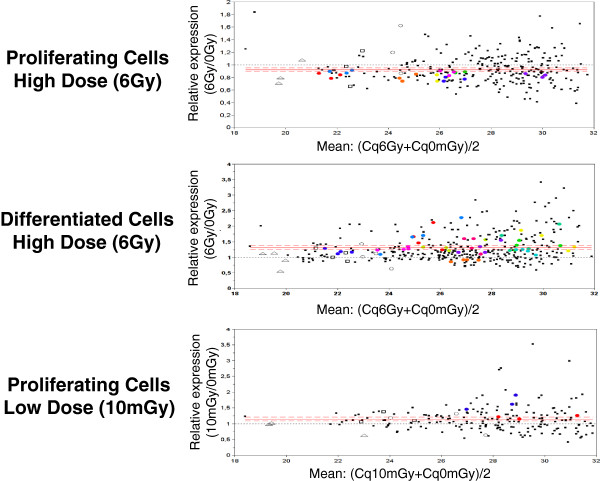
Relative miRNA expression profiling for all cell samples. Each dot corresponds to one miRNA analyzed in one cell sample. The mean Cq is plotted on the X axis whereas the relative expression (2ΔΔCq) is plotted on the Y axis. Continuous and discontinuous red lines represent respectively mean and SD response to irradiation for all samples. The black dot line corresponds to miRNAs with the same Cq in irradiated and non-irradiated samples. Colored dots represent significantly modulated miRNA (bilateral paired t-test p<0.05, n=3 or n=4). Empty dots represent control small RNAs RNU6-1 (triangle), SNORD44 (circle) and SNORD48 (square) response to ionizing irradiation.